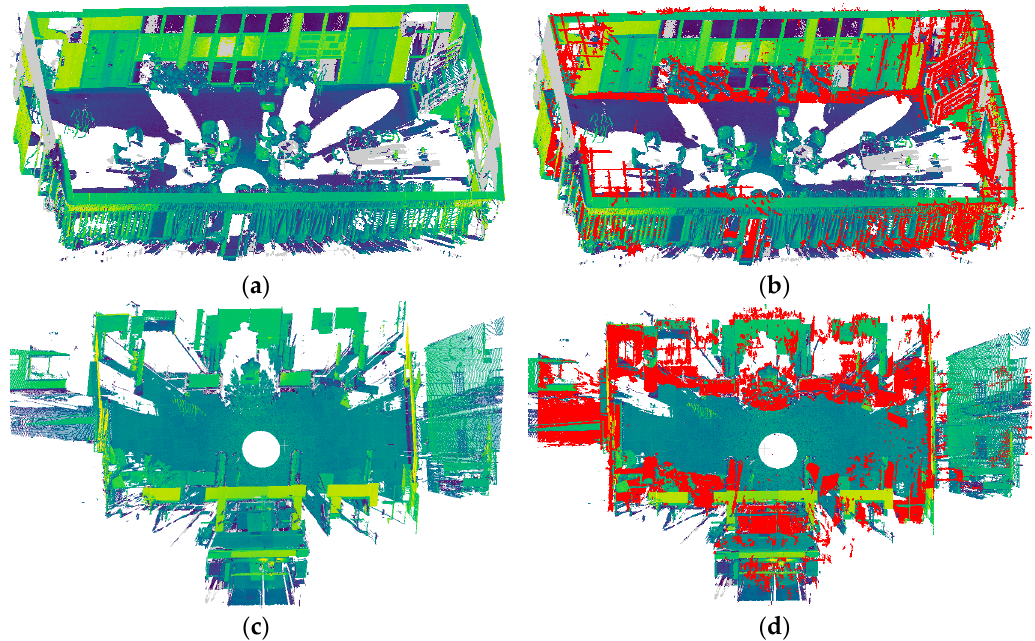
Figure 10 . Comparison of hierarchical SfM reconstructed point cloud models (in red color) with the TLS point cloud models. ( a ) and ( c ) are the TLS point clouds of the meeting room and lobby, respectively. Figures ( b ) and ( d ) show the annotated hierarchical SfM reconstructed point models registered to the TLS points. Table 9. Registration error of the proposed SfM reconstructed point clouds and TLS point clouds (cm).